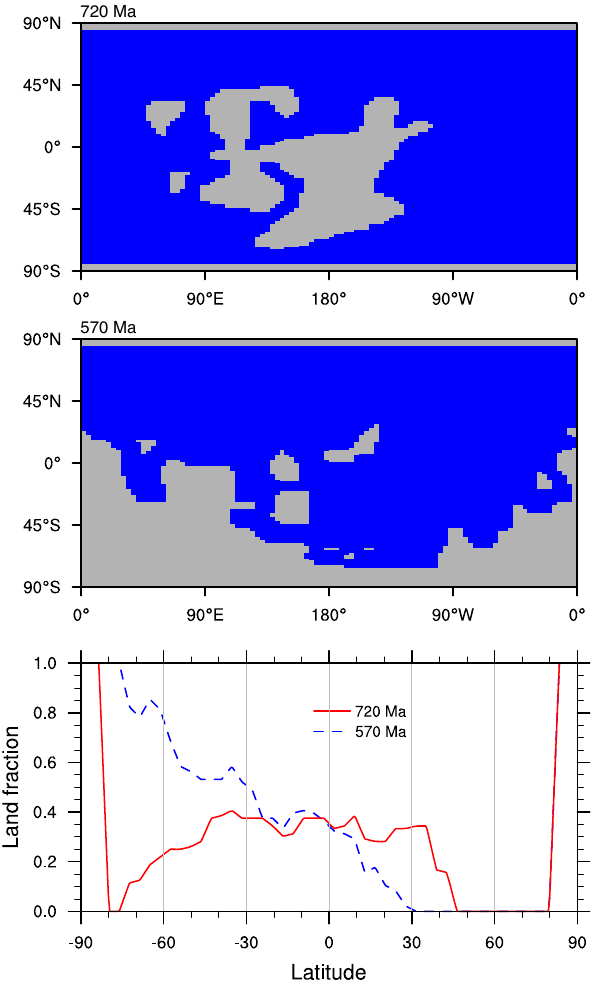
Fig. 1. The continental configuration for 720Ma and 570Ma, and their zonal land fractions. Grey and blue are land and ocean, respec- tively. Note that fictitious land has been added at the two